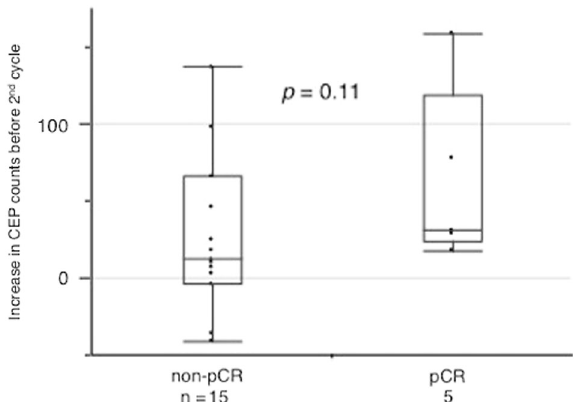
Fig. 4 The increase in CEP counts between 1st and 2nd cycle of chemotherapy according to the pCR status. The y-axis indicates the increase in CEP counts between 1st and 2nd cycle. Patients with pCR tended to showed a greater increase in CEP counts ( p = 0.11, Mann